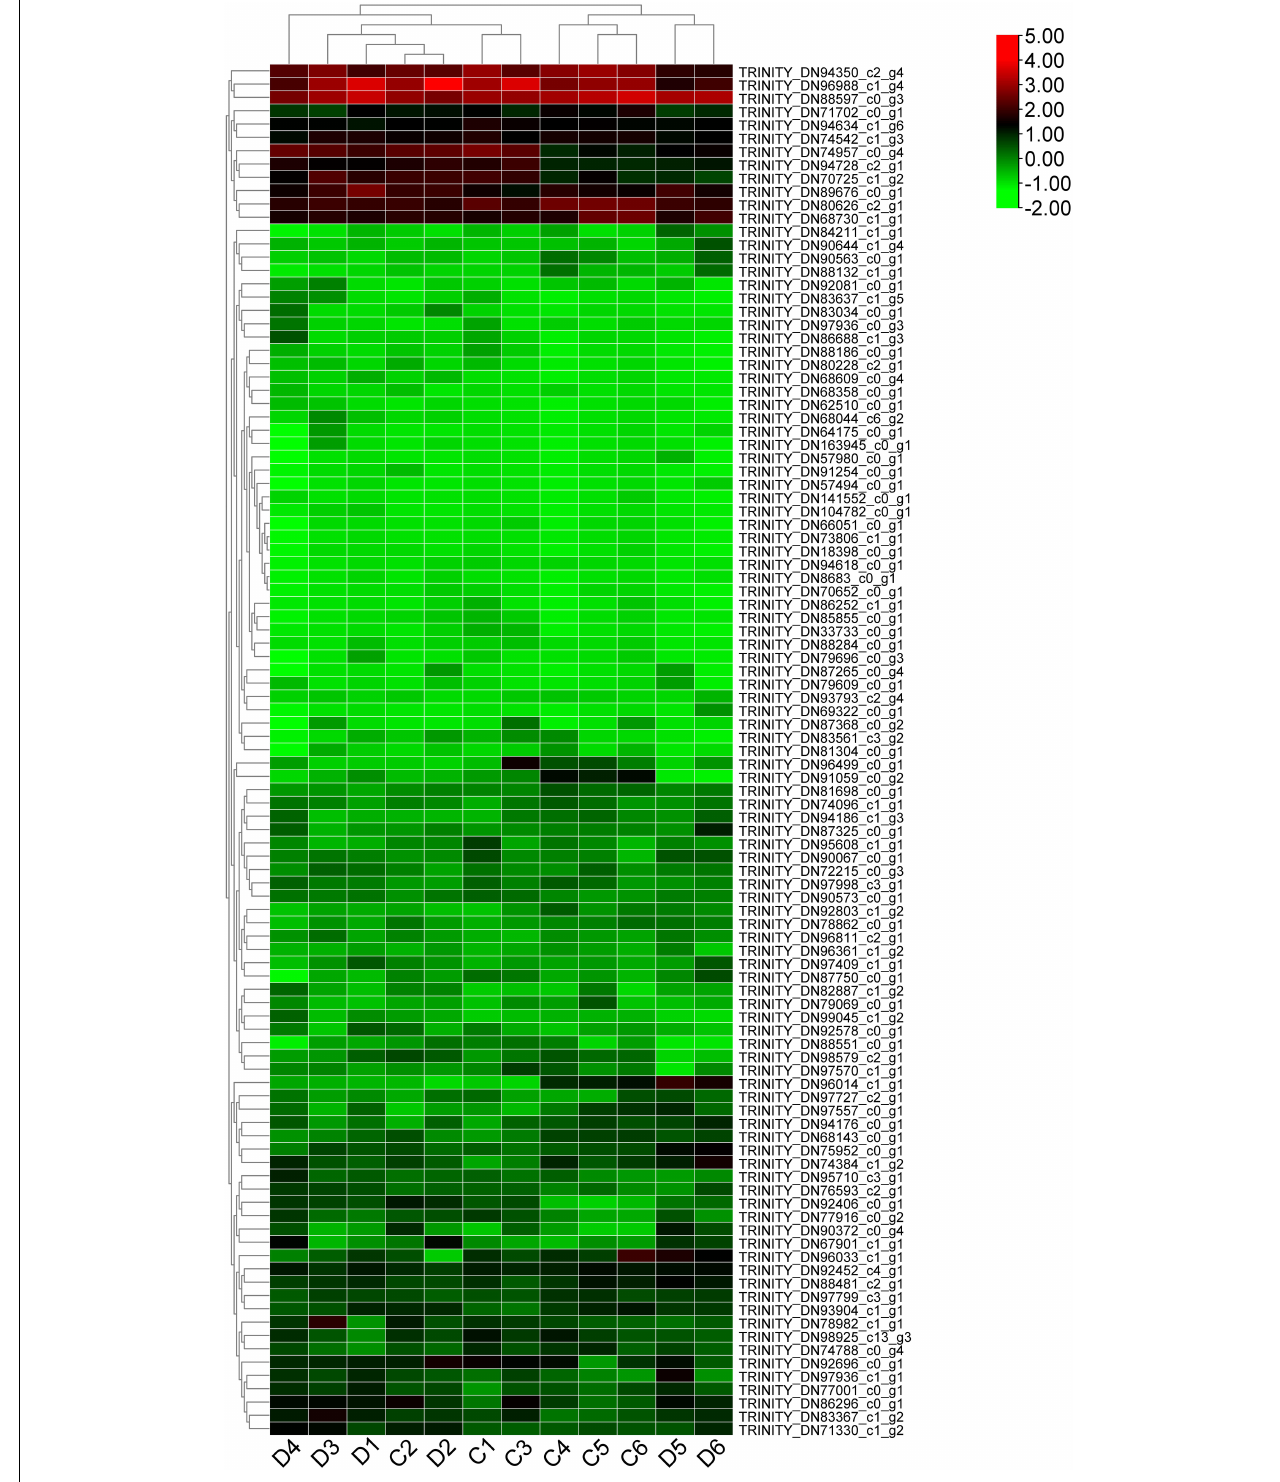
Frontiers in Plant Science |